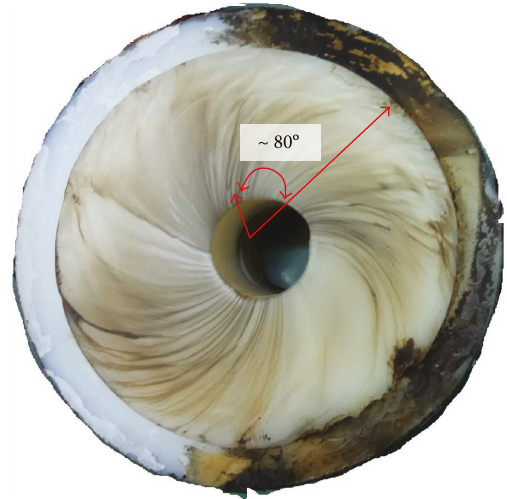
Figure 15: Swirl pattern on fuel grains of disk chamber 1 after hot- fi re